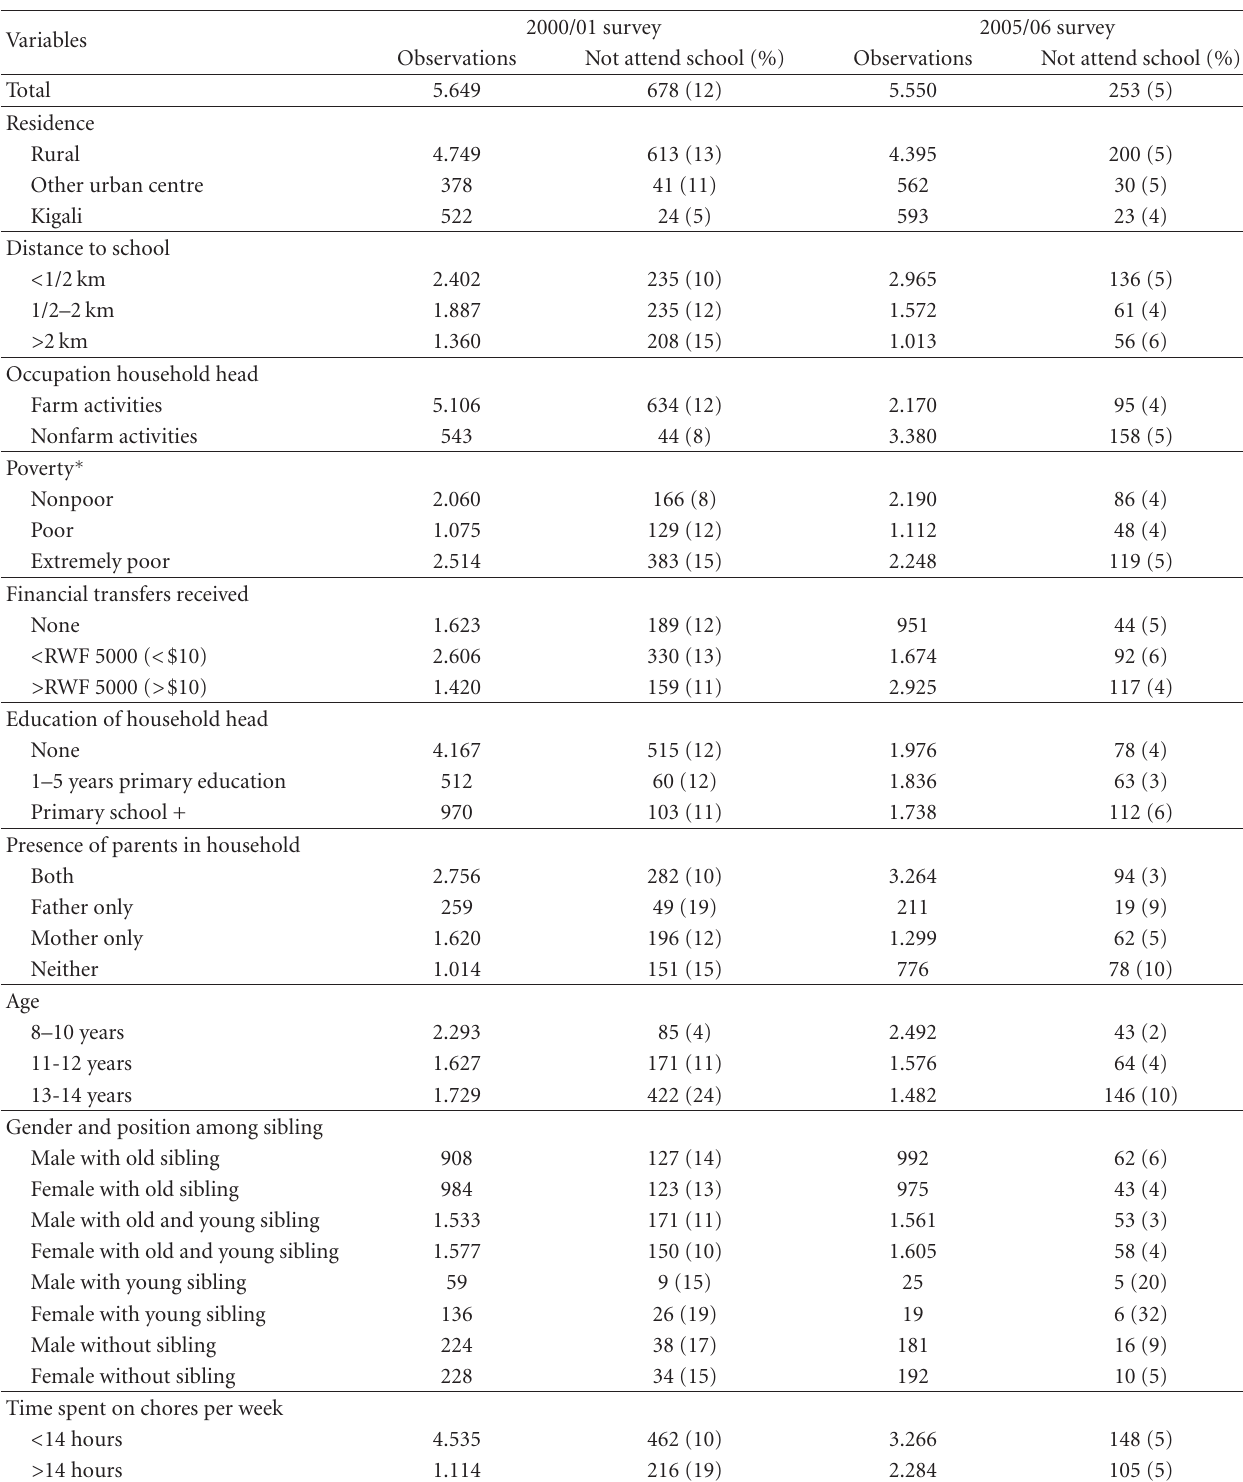
Table 1: Descriptive statistics on the independent variables influencing the nonattendance at school for children aged 8–14 years during EICV 2000/01 and